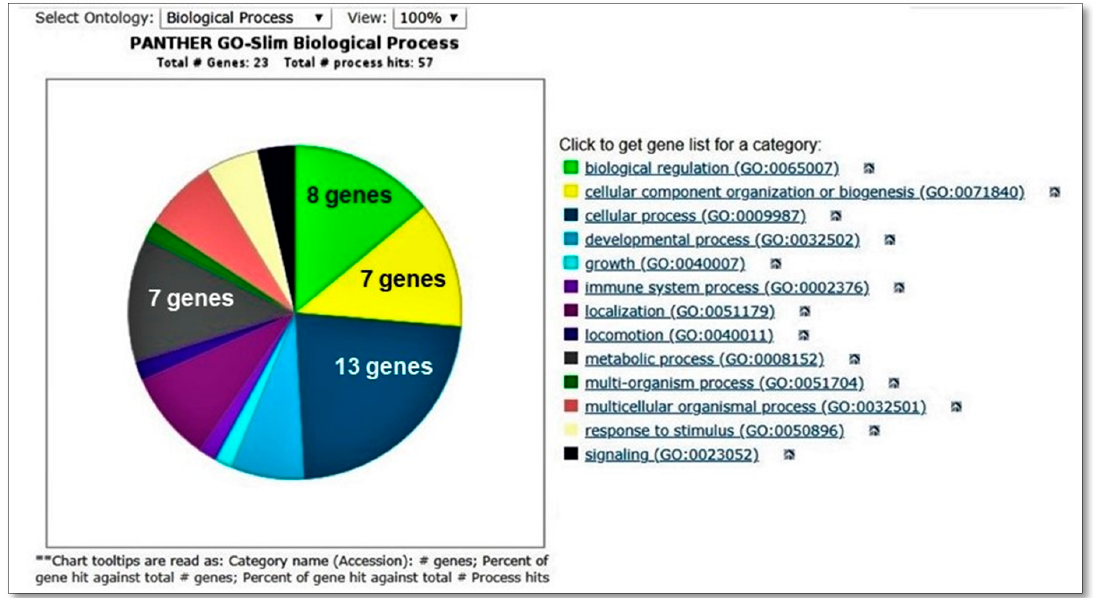
Figure 10. Pie-chart showing major biological processes that the differentially expressed proteins can be mapped to the analysis was performed using the Panther Classification system